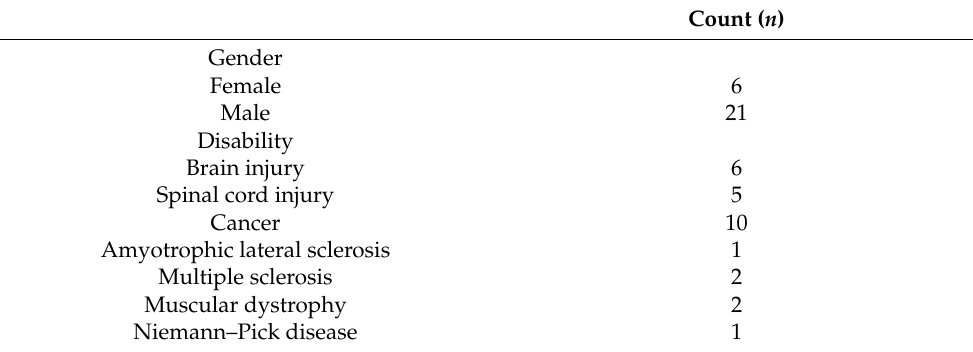
Table 1. Participants’ profiles and types of